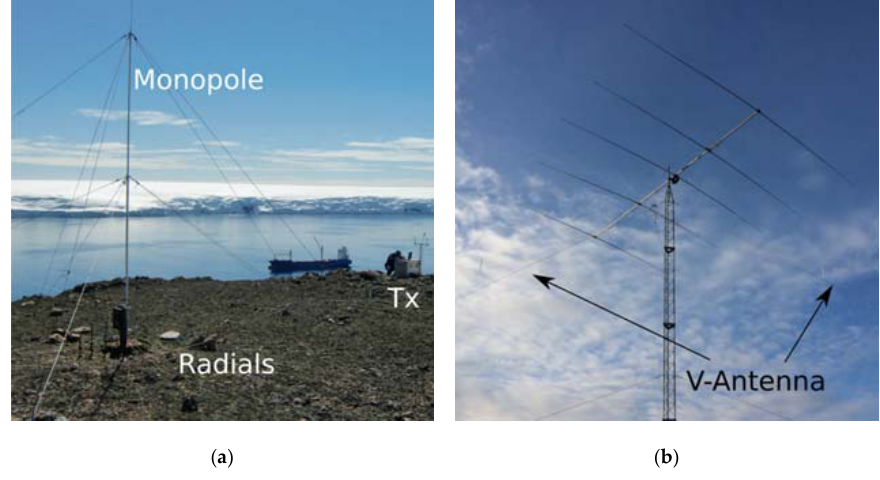
Figure 2. Geographical link characteristics. The transmitter ( a ) is located in the Spanish Antarctic Station on Livingston Island, and the receiver ( b ) is placed in Cambrils, Figure 2. ( a ) The transmitting antenna in the Antarctica, a 7.5 m rugged monopole with 32 radials; ( b ) The receiving antenna 80 in Cambrils, the inverted ‐ V antenna (see the two higher wires hanging from the big mast). 81